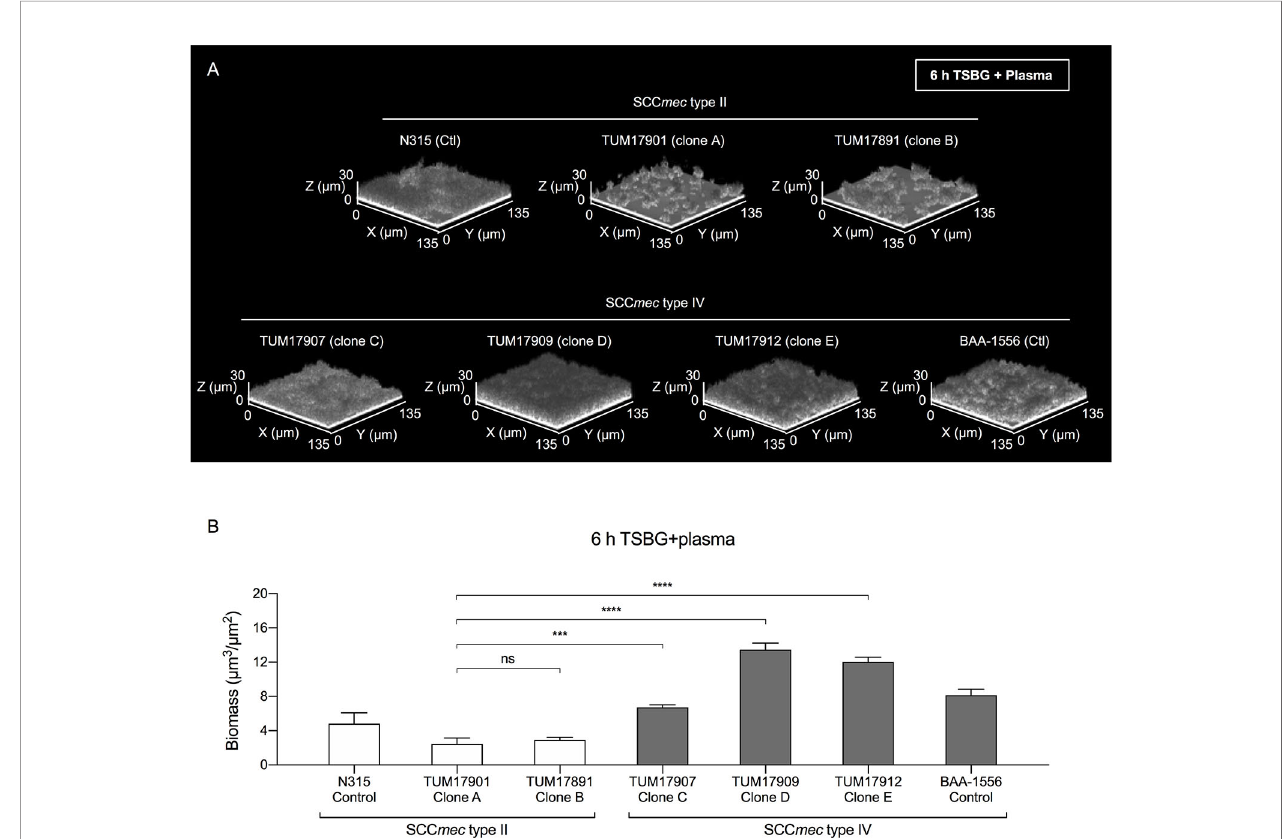
FIGURE 3 | Visualization of bio fi lms by confocal re fl ection microscopy (CRM). (A) Bio fi lm in the presence of plasma (Plasma-bio fi lm) structures of the strain selected from each clone. (B) Comparison of the biomass of plasma-bio fi lms calculated by image analysis. Using a CRM method, the plasma-bio fi lm structures of each experimental strain and control strain (BAA-1556 and N315) were observed, and the biomass was measured by image analysis using a COMSTAT2 program. The biomass of plasma-bio fi lms was calculated in four fi elds of view and the means were compared. The results were con fi rmed by two independent experiments. *** p < 0.001, **** p < 0.0001; one-way ANOVA followed by Tukey ’ s multiple comparison test was used in (B) . TSBG, tryptic soy broth containing 0.5% glucose; ns, not signi fi cant. Fields: 135×135×30 m m ( xyz ) are